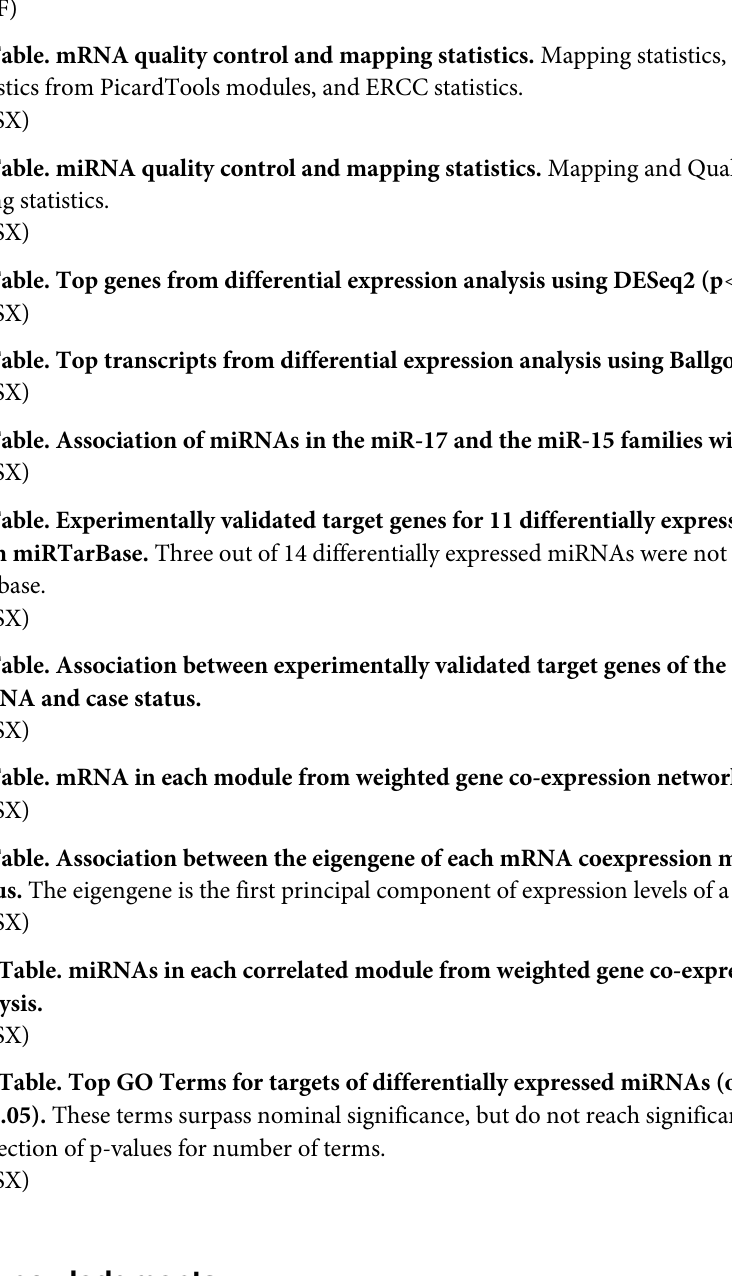
S1 Fig. A heat map of the normalized count of miRNAs with nominal p-value < 0.01 in dif- ferential expression analysis. Hierarchical clustering was conducted using Euclidean distance and the Ward’s criterion [48]. S2 Fig. Summary of mRNA and miRNA analyses and results in this study. (PDF) S1 Table. mRNA quality control and mapping statistics. Mapping statistics, Quality Control statistics from PicardTools modules, and ERCC statistics. S2 Table. miRNA quality control and mapping statistics. Mapping and Quality Control fil- tering statistics. S3 Table. Top genes from differential expression analysis using DESeq2 (p < 1x10 -4 ). S4 Table. Top transcripts from differential expression analysis using Ballgown (p < 1x10 -3 ). S5 Table. Association of miRNAs in the miR-17 and the miR-15 families with case status. S6 Table. Experimentally validated target genes for 11 differentially expressed miRNAs from miRTarBase. Three out of 14 differentially expressed miRNAs were not available in the database. S7 Table. Association between experimentally validated target genes of the significant miRNA and case status. S8 Table. mRNA in each module from weighted gene co-expression network analysis. S9 Table. Association between the eigengene of each mRNA coexpression module and case status. The eigengene is the first principal component of expression levels of a module. S10 Table. miRNAs in each correlated module from weighted gene co-expression network analysis. S11 Table. Top GO Terms for targets of differentially expressed miRNAs (one-tailed p < 0.05). These terms surpass nominal significance, but do not reach significance after BH correction of p-values for number of